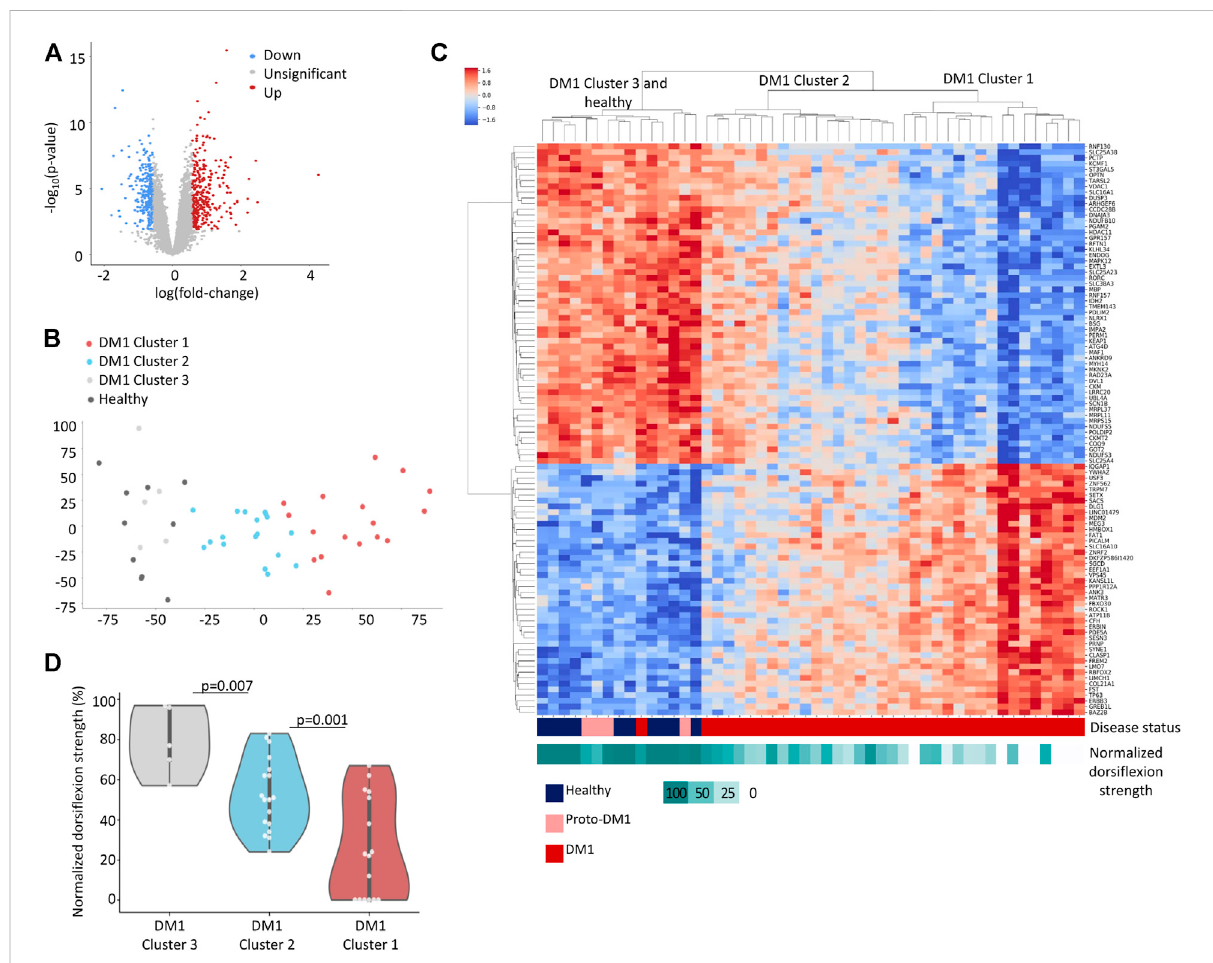
FIGURE 1 DM1 gene expression signature. (A) Volcano plot displaying differentially expressed genes between 40 DM1 patients and 10 healthy individuals. 1.5-fold change upregulated genes are highlighted in red, 1.5-fold change downregulated genes are highlighted in blue. (B) PCA analysis of normalized gene expression values for Tibialis DM1 and healthy samples. (C) Heatmap of normalized expression levels of [top 100 loading score (Jolliffe, 2011)] genes across Tibialis samples from 40 DM1 patients and 10 healthy individuals. The rows and columns are ordered based on hierarchical clustering (by the UPGMA method). Each row represents a single gene, and each column represents a sample. The colors indicate the normalized expression levels from high (red) to low (blue). The normalized dorsi fl exion strength score of each individual is depicted in the bottom bar, ranging from white (lowest score) to cyan (highest score). (D) Normalized dorsi fl exion strength scores of healthy individuals and DM1 patients, grouped according to the clusters formed in Figure